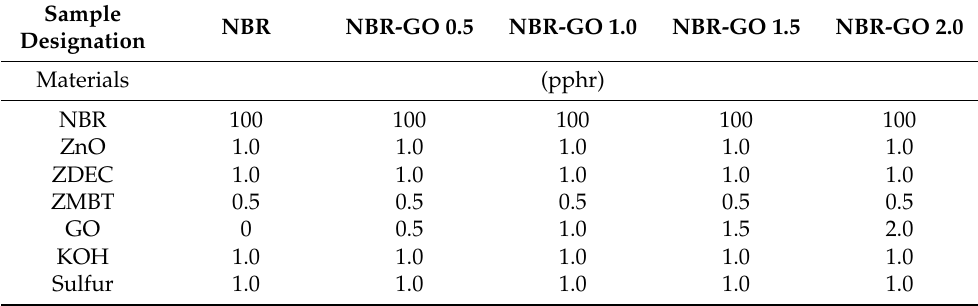
Table 1. Formulation for membrane